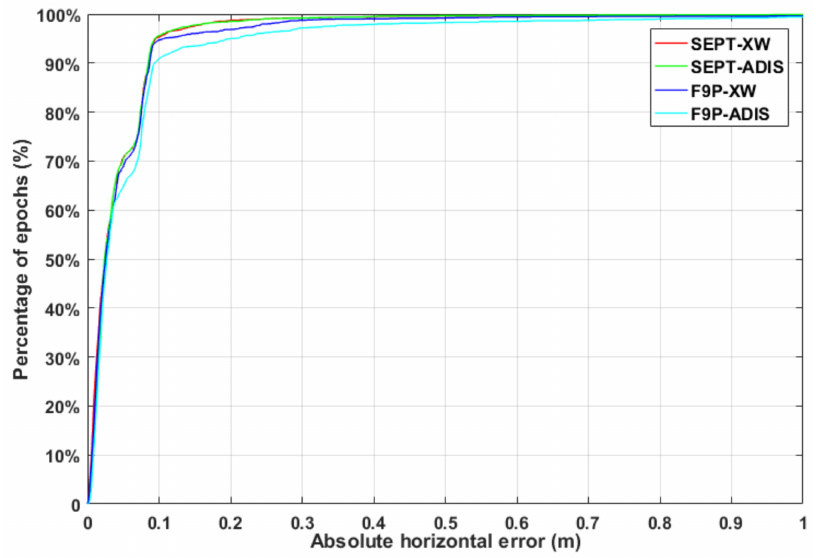
Figure 14. The percentage of horizontal positioning error does not exceed the specified threshold under different schemes in experiment